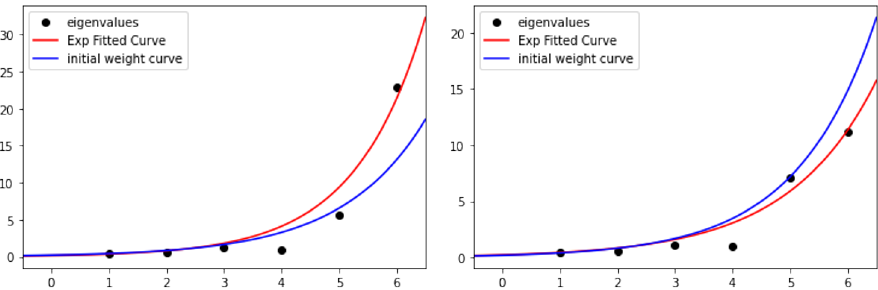
Figure 2 . Two solutions for L 24 ( k = 1000) with exponential fit loss ∼ 4 . 55 , 1 . 02 (left, right respectively). These are found among the 12 solutions for this functional, of which there are 5 distinct solutions. Unlike in figure 1, this functional had different local minima. If we were to randomly simulate 10,000 functions similar to section 4.3, but with the additional constraints that 0 . 85 max ≤ max ( j ) ≤ max and that the exponent b > 0 , once for the left solution 1 ≤ j ≤ 2 N f max ∼ 22 . 8 and once for the right solution max ∼ 11 . 16 , then the loss of the left and right solutions would be higher than 3.95%, 0.97% of the random losses.